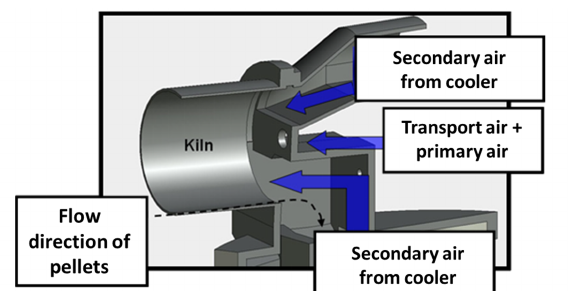
Figure 2. One of the two types of kiln hoods used in LKAB’s pelletizing processes, this geometry has been the main focus of the work presented here. Courtesy of